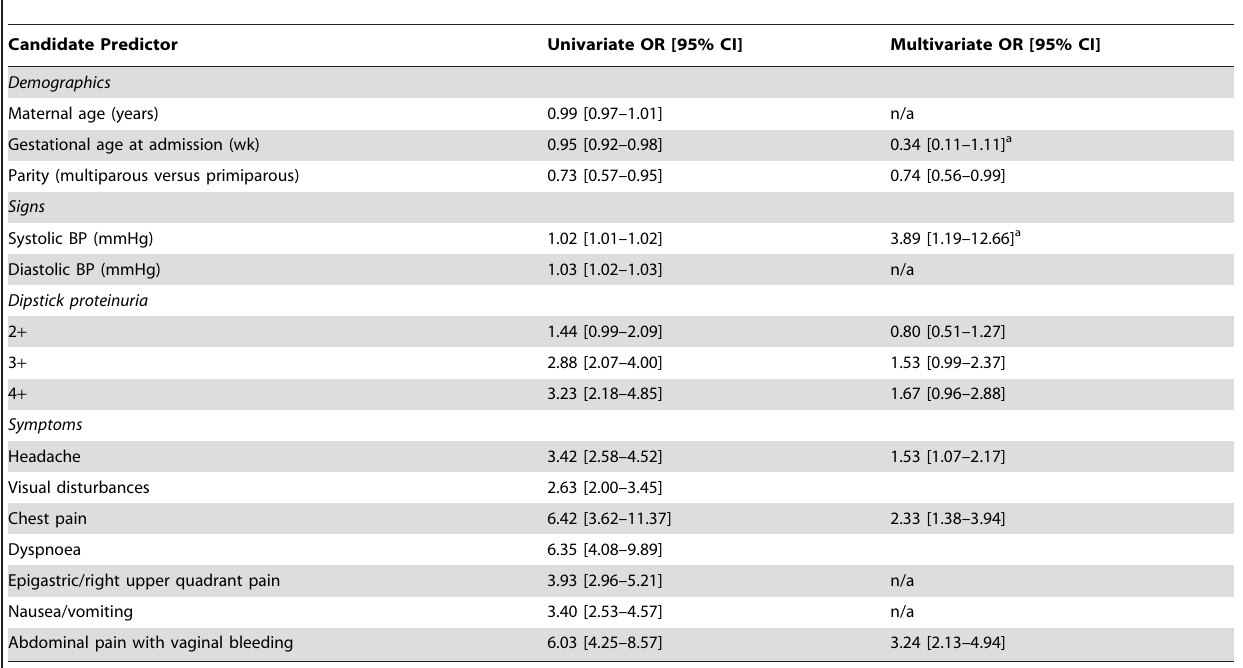
Table 3. Univariate and multivariate analysis of candidate predictors in the miniPIERS cohort.